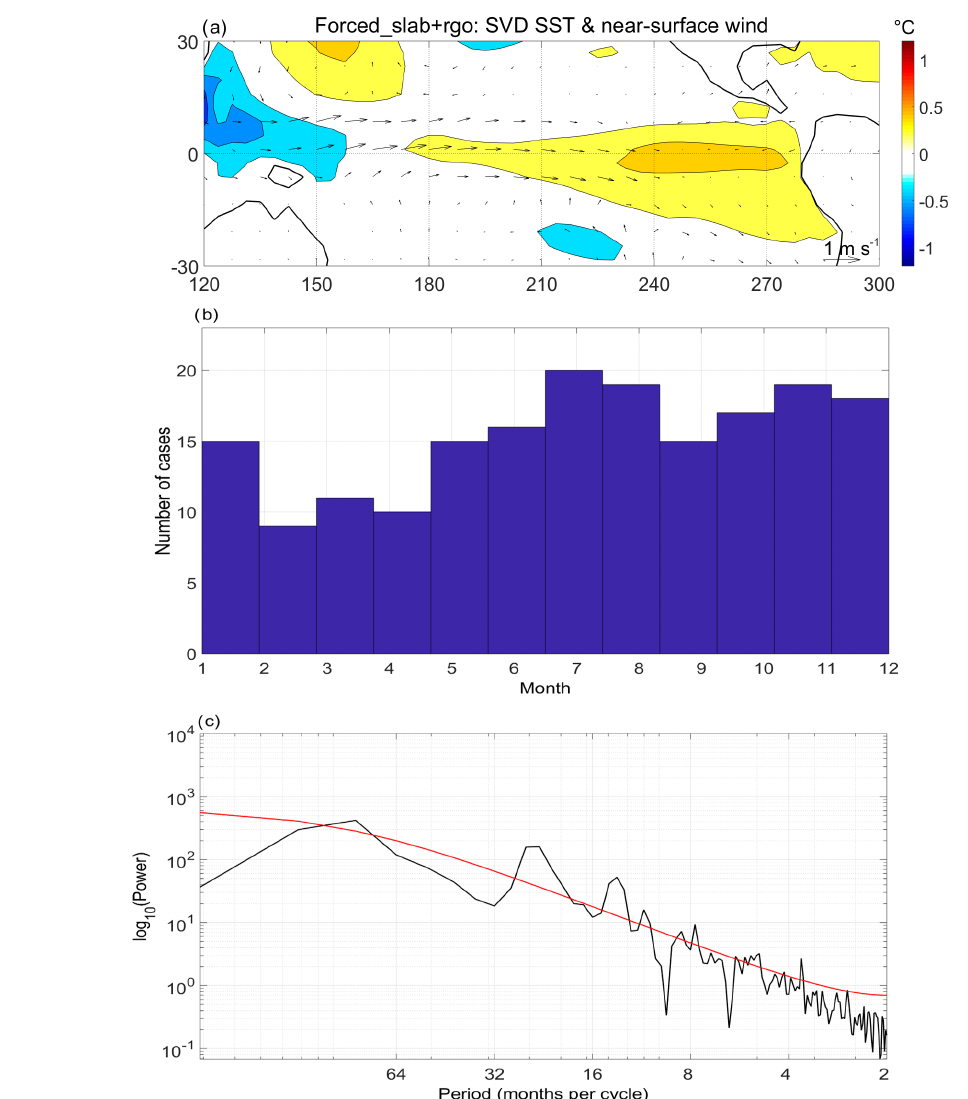
Figure 12. First SVD pattern of SST and near-surface winds in the tropical Pacific Ocean (30 ◦ S–30 ◦ N, 120–300 ◦ E) for the Forced_slab + rgo experiments. (a) Spatial pattern; contour interval 0.2 ◦ C. (b) Histogram showing phase-locking to the seasonal cycle. (c) Spectral analysis; the red line indicates the red-noise